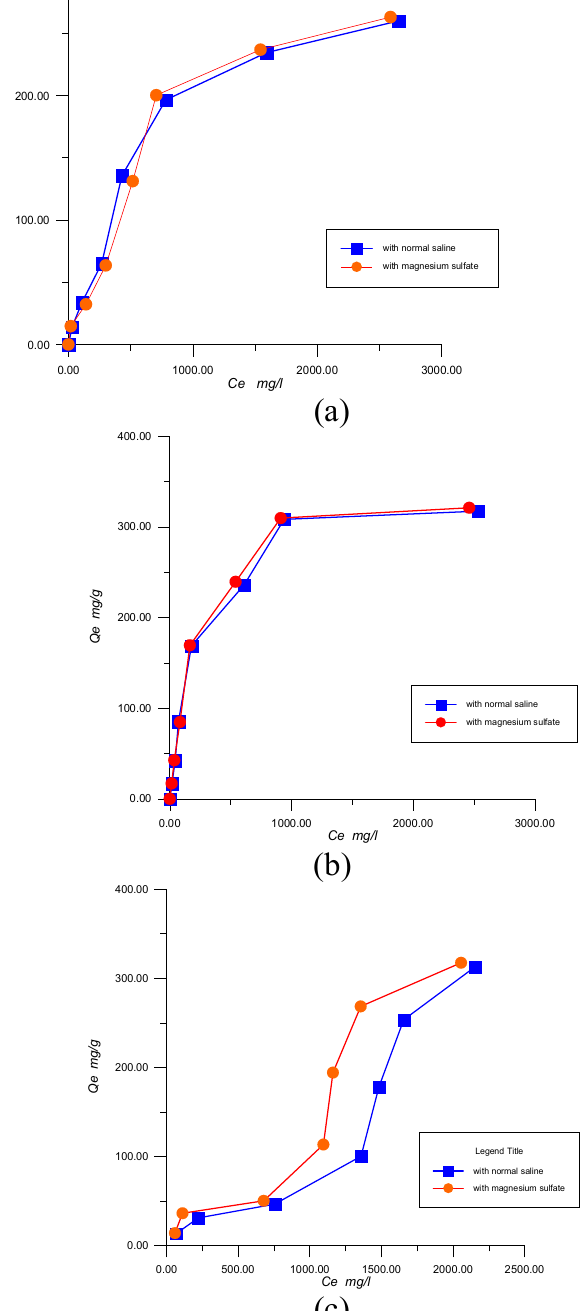
Figure 5: Adsorption isotherms of the (a) amitriptyline HCl , (b) chlorpromazine HCl (c) chlordiazepoxide HCl on bentonite using magnesium sulfate solution and normal saline at 37.5 o